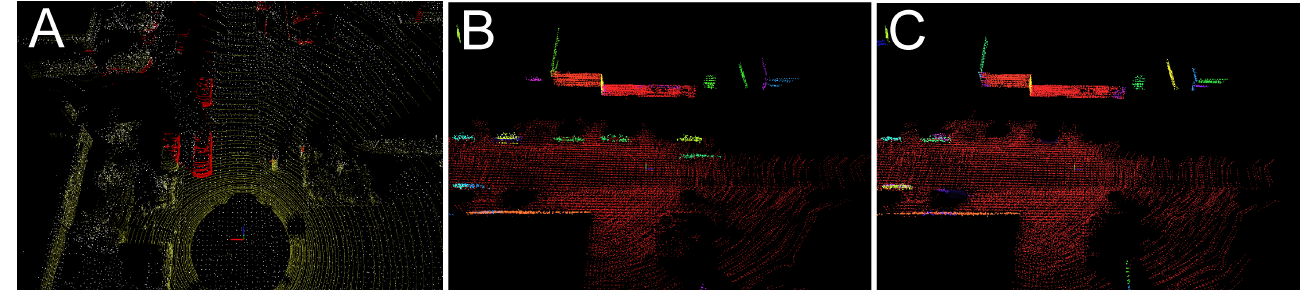
Figure 16. Example views of the PlaneLOAM maps created for the sequence 01 from the KITTI MOTS dataset: removal of non-stationary objects (red points) ( A ), a map created by the PlaneLOAM system without motion filtering showing planar features corresponding to moving cars ( B ), and a map created by the PlaneLOAM + Filter variant that does not contain these features—note that some parked cars are still represented in the map ( C ).